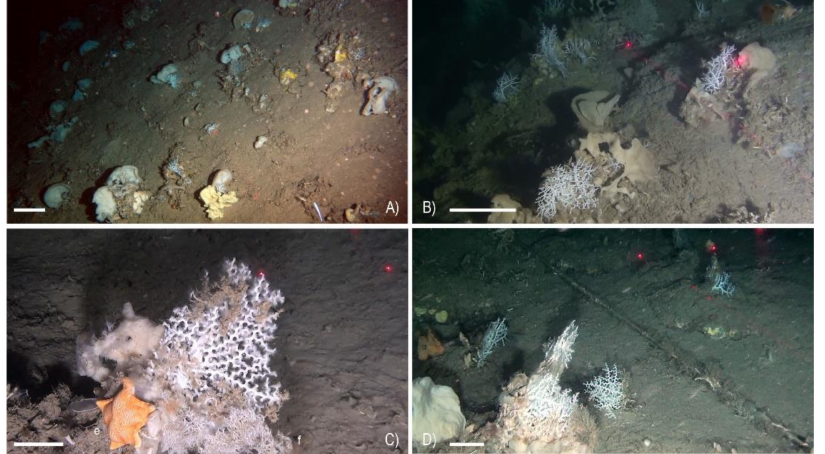
Figure 2. Examples of habitats and threatened benthic organisms recorded in the Bari Canyon. ( A ) Aggregation of deep-sea sponges (=sponge ground) dominated by the white large fan-shaped sponge Pachastrella monilifera (white) at ca. 486 m depth; scale bar = 20 cm. ( B ) Aggregation of deep-sea sponges and the scleractinian Madrepora oculata at ca. 250 m depth; scale bar = 20 cm. ( C ) Madrepora oculata settling on a rocky outcrop together with the echinoderm ( e ) Peltaster placenta and the colonial annelid ( f ) belonging to the Filograna/Salmacina complex at depth of ca. 230 m; scale bar = 10 cm. ( D ) Abandoned/lost longline in cold-water coral habitat, dominated by Madrepora oculata at ca. 280 m depth; scale bar = 20